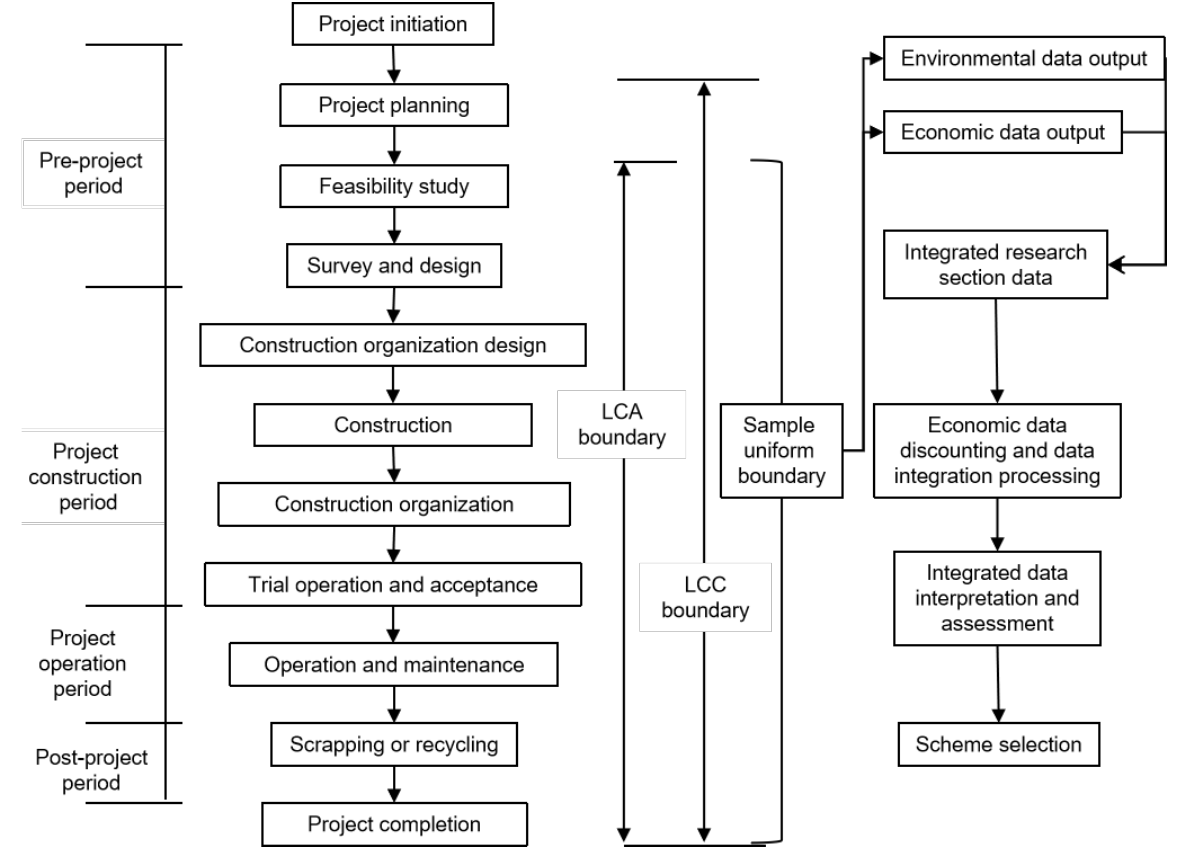
Figure 1. LCA-LCC integration assessment framework.